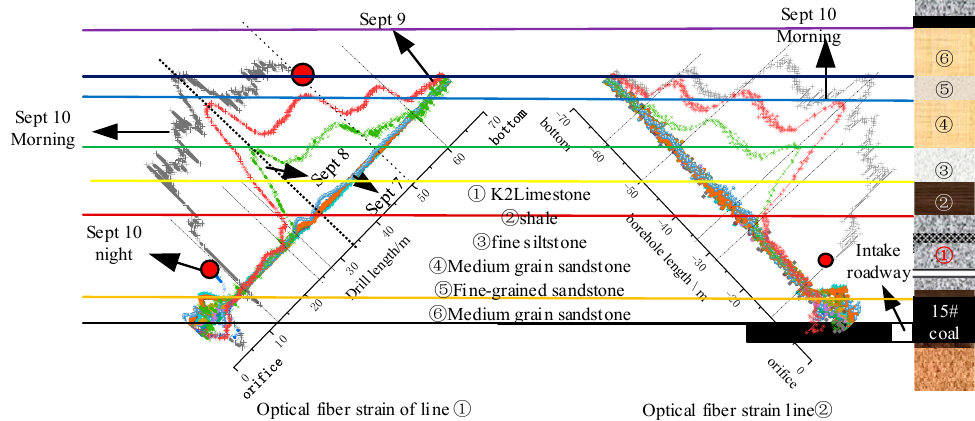
Figure 27. Stratigraphic comparison of strain curve of steel strand optical fiber in line ① and line ② .